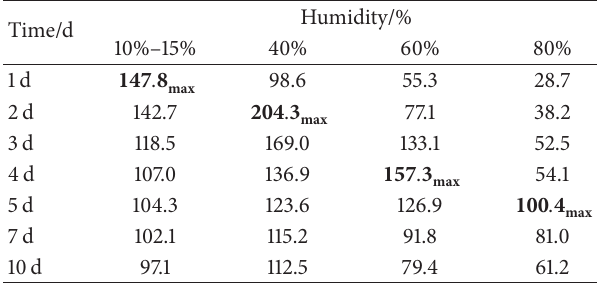
Table 3: The relationship between curing humidity, time, and strength (uniaxial compressive strength,